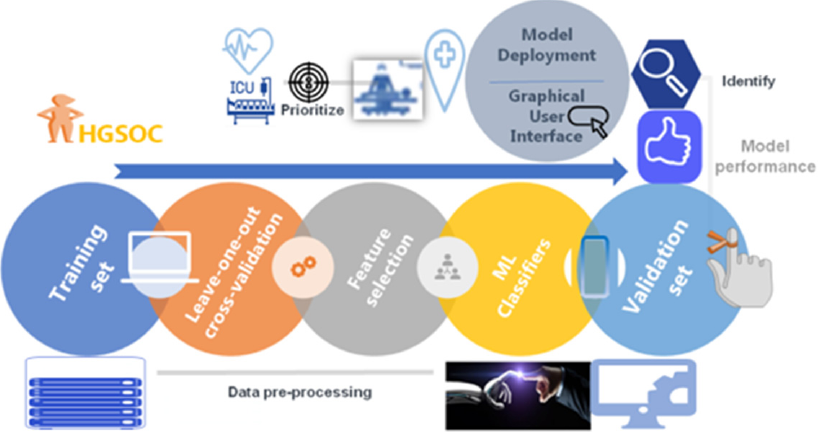
Figure 1. Machine Learning (ML) Model derivation and validation flow from a fully curated source of advanced stage high grade serous ovarian cancer patient and surgical data. The framework comprised data pre-processing with feature selection and model training. The model was evaluated using performance metrics prior to the development of an ML-based nomogram and a web application to help with risk assessment.